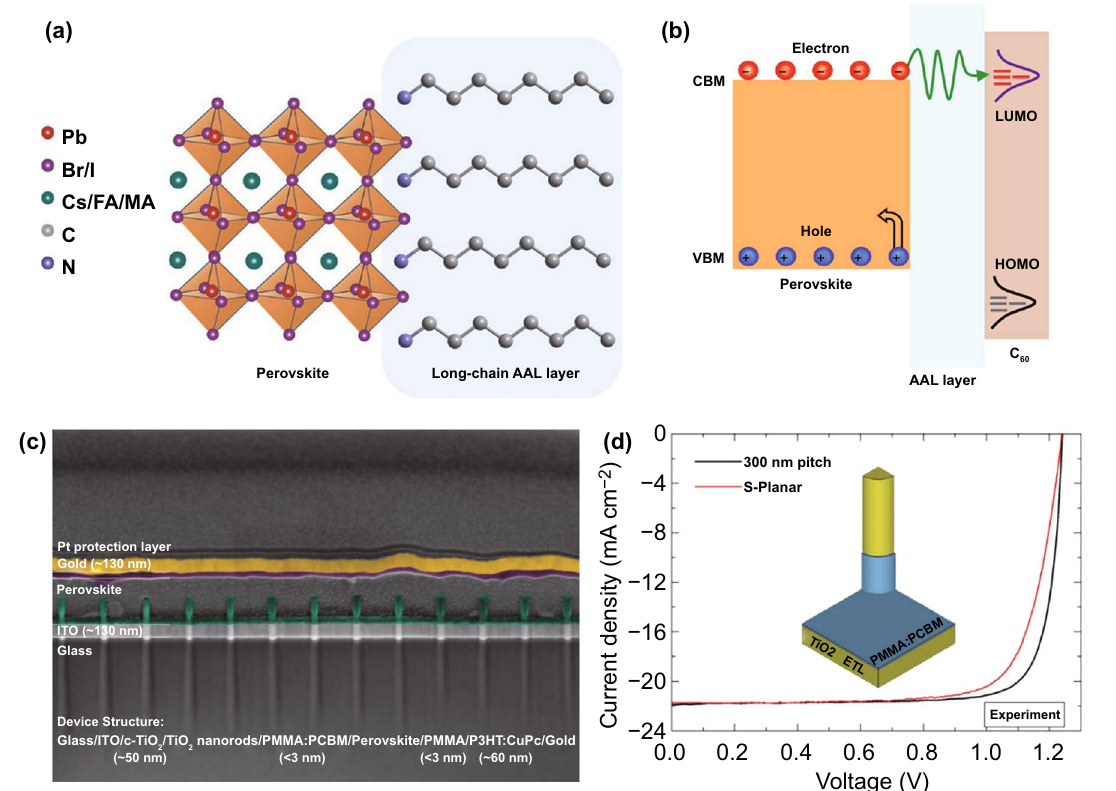
Fig. 2 a Illustration of the long-chain AALs assembled on perovskite film surface. b The electron-tunneling and hole-blocking effects induced by AAL layer at the perovskite/C 60 interface, VBM and CBM represent the valence band maximum and conduction band minimum of perovs- kite semiconductor, respectively. Reproduced with permission from Ref. [35] Copyright 2020 Nature Publishing Group. c Cross-sectional SEM image of the PSCs designed with TiO 2 nanorod pattern at the bottom surface of perovskite layer. d Experimental J-V curves of the PSCs based on planar (reference cell) and the TiO 2 nanopattern structure, 300 nm pitch represents the TiO 2 nanorods with a spacing of 300 nm in devices, the inset shows that about 30% of the nanorod is coated with insulating passivation layer. Reproduced with permission from Ref. [37]